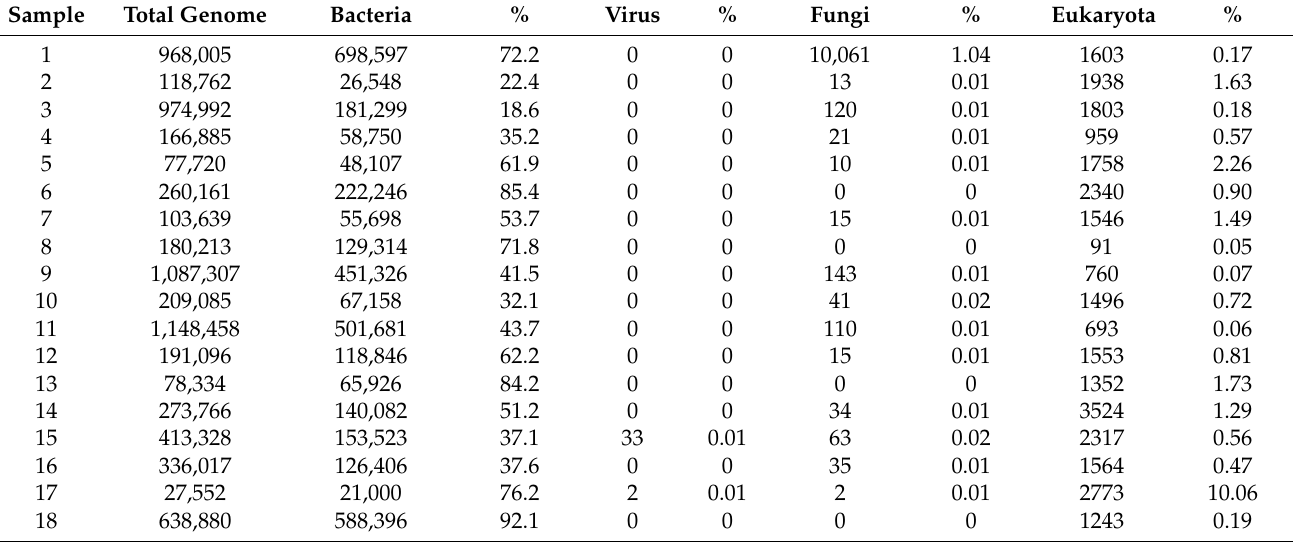
Table 3. Read summary of metagenomic shotgun sequencing analysis of canalicular